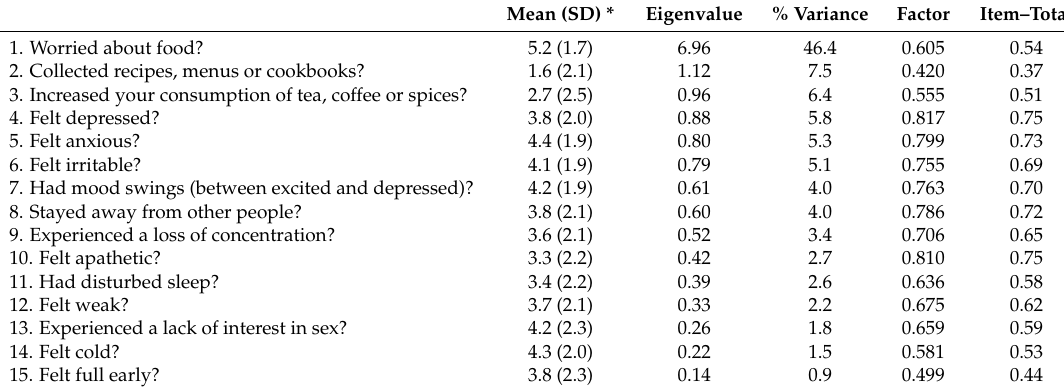
Table 1. 15-Item Starvation Symptom Inventory: means (standard deviations), eigenvalues, percentages of variance, factor loadings and item–total correlations in the anorexia nervosa sample. Mean (SD) * Eigenvalue % Variance Factor